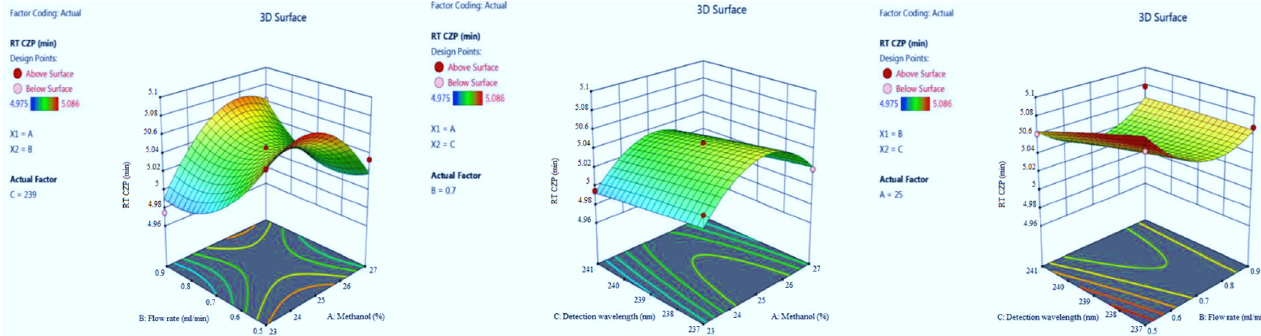
Figure 7. 3D responses for CZP retention time in terms of AB, AC, and BC.